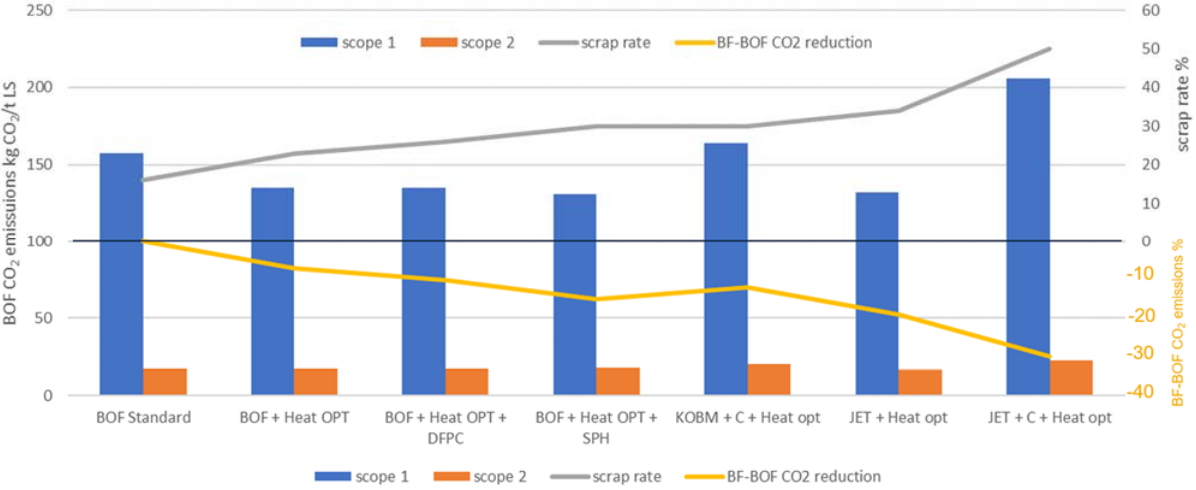
Figure 14. Specific CO 2 emissions (scope 1 and scope 2) per ton of liquid steel (LS) for different BOF solutions, including possible scrap rate and potential for reduction in total BF–BOF CO 2 emissions. Variation depending on operation conditions possible.